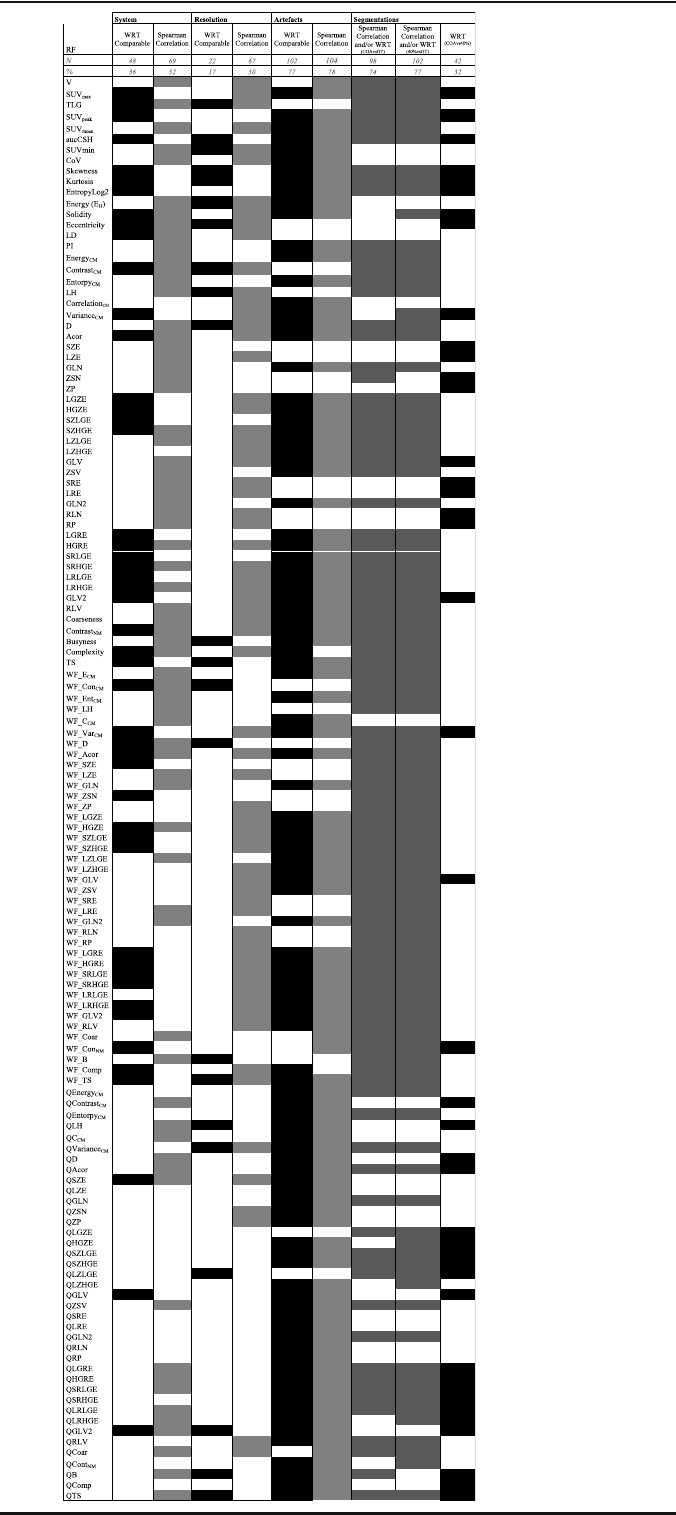
Table 2 Results of RF analysis. Filled box means positive result for the analysis described on the first row (black is comparable, and gray is strongly correlated) and represents the property of interest, like for example, RF robust to the different PET/CT systems (second